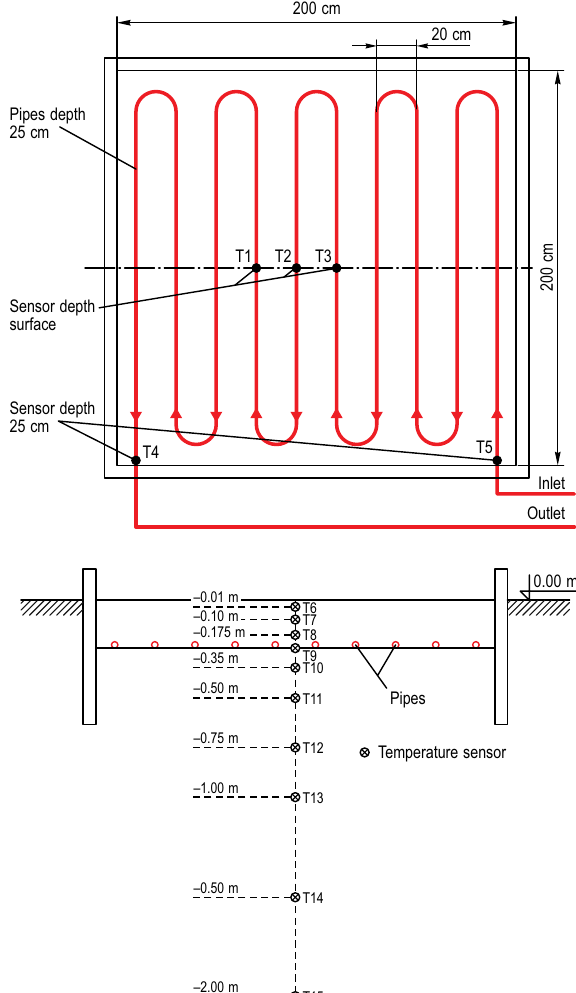
Fig. 6. Schematic of measuring point in tested